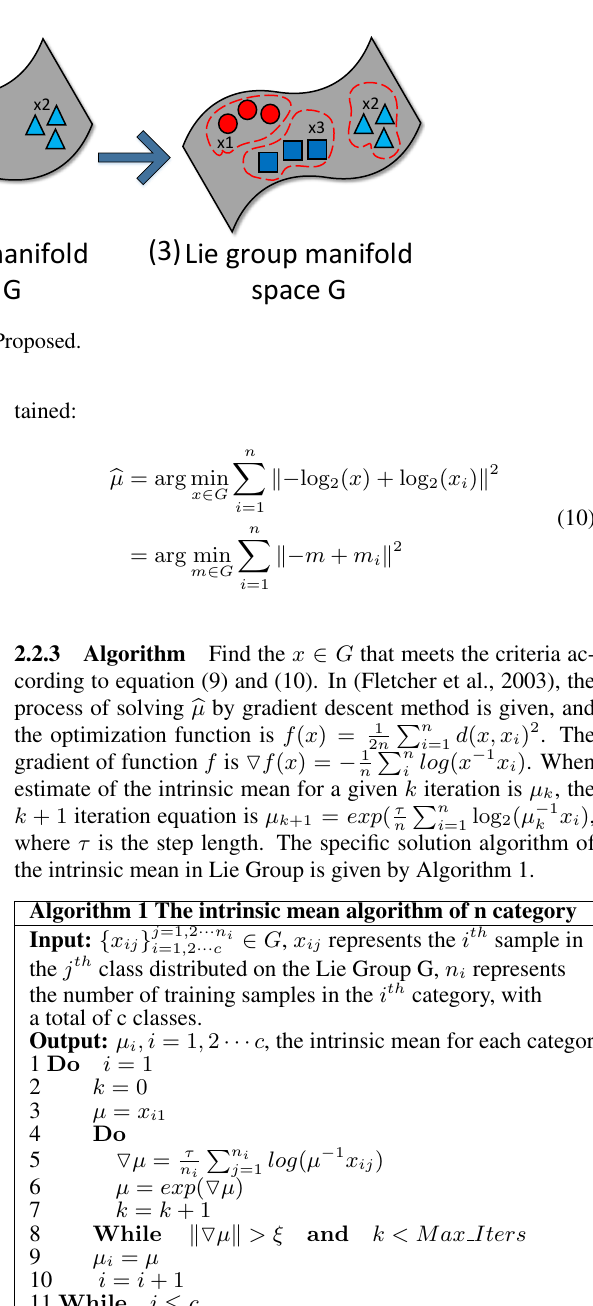
Figure 1. Difference of intrinsic mean and extrinsic mean.